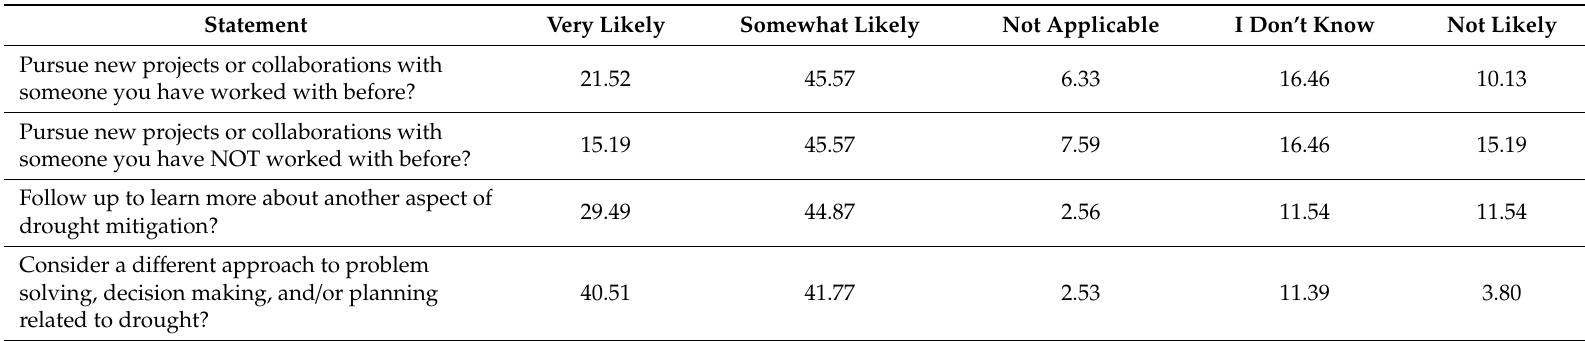
Table 2. Responses of the participants (in percent of received responses) to a question about their recommended purpose of the game. Di ff erence in responses between students and professionals was measured using Person’s Chi Squared and is presented using the associated probability value. Purpose S / P 1 Yes Maybe No Di ff erence in Response Networking among stakeholders. Learning about drought impacts. Improving communication among stakeholders. Demonstrating the importance of communication and coalitions.